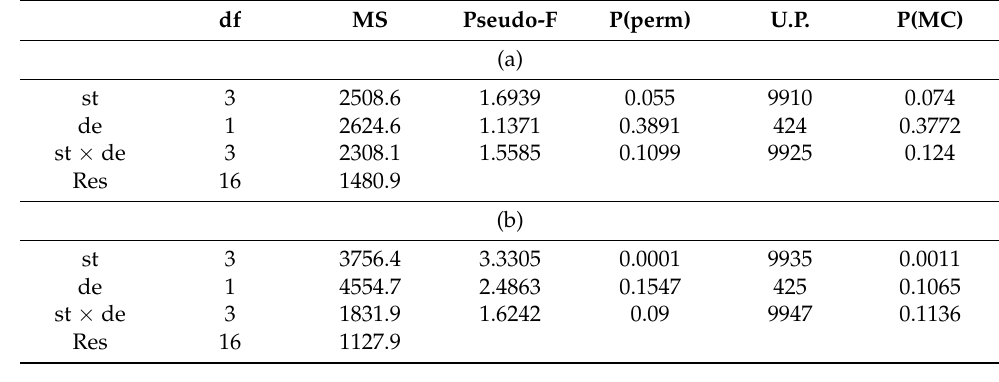
Table 3. PERMANOVA testing differences in assemblages’ distribution patterns among stations and between depths. Analyses carried out on the original data matrix (a) and the presence/absence matrix (b) st = station, de = depth, df = degrees of freedom, MS = mean squares, Pseudo-F = statistics, P (perm) = p -values calculated by permutations, P(MC) = p -values calculated by Monte Carlo sampling, U.P. = unique perms, Res = residuals.